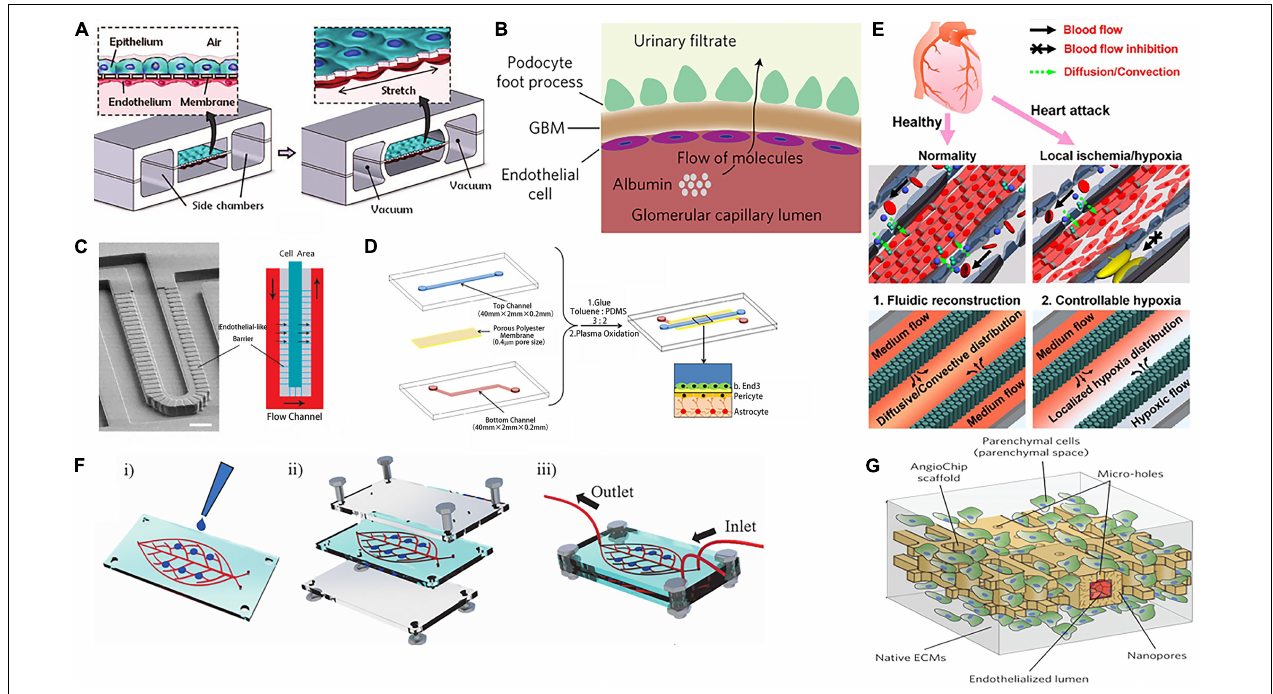
FIGURE 2 | Vascularization of organoids using various methods. (A) The alveolar epithelial cells and the vascular endothelial cells with flexible PDMS membrane form an alveolar-capillary barrier. Adapted from Huh et al. (2010). Reprinted with permission from AAAS. (B) Schematic representation of glomerular capillary wall with podocytes and endothelial cells that form a filtration barrier. (C) SEM micrograph and structure diagram of microfluidic chip simulates the hepatic sinusoid model. (D) Endothelial cells, pericytes, and astrocytes construct the blood–brain barrier (BBB). (E) The microfluidic device for studying controllable myocardial hypoxia and for myocardial fluidic microenvironment mimicking. (F) Human-on-leaf-chip simulates the complex vascular network structure of the human body. (G) AngioChip with branching interconnected lumen composed of POMaC and biological